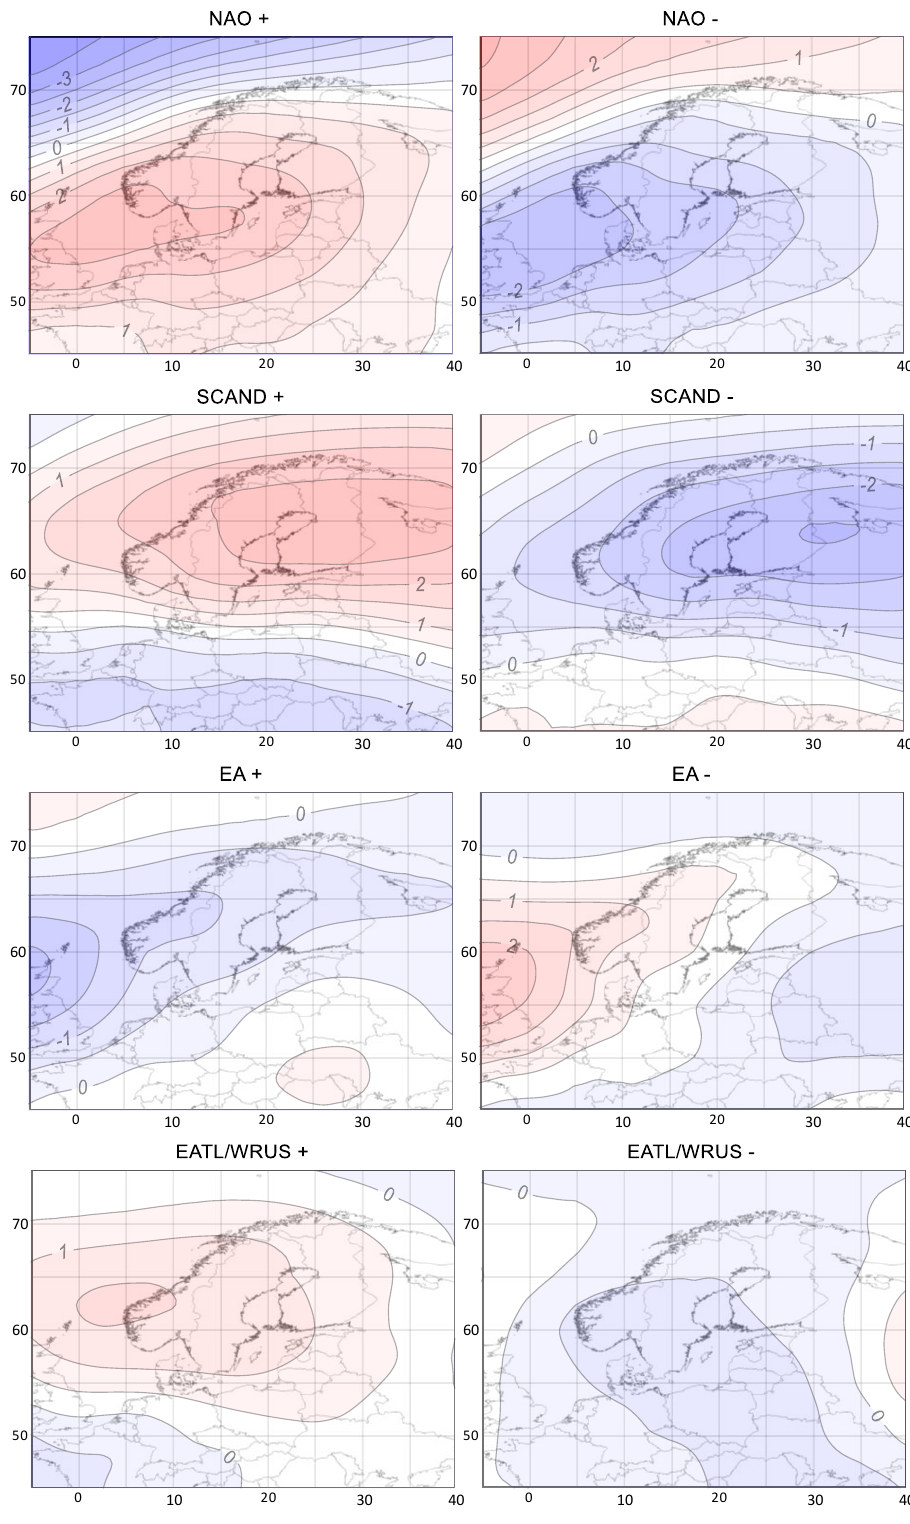
Figure A1. Anomalies of SLP in positive (left) and negative (right) phase of macroscale circulation patterns based at the first (negative phase) and the third (positive phase) quartile.